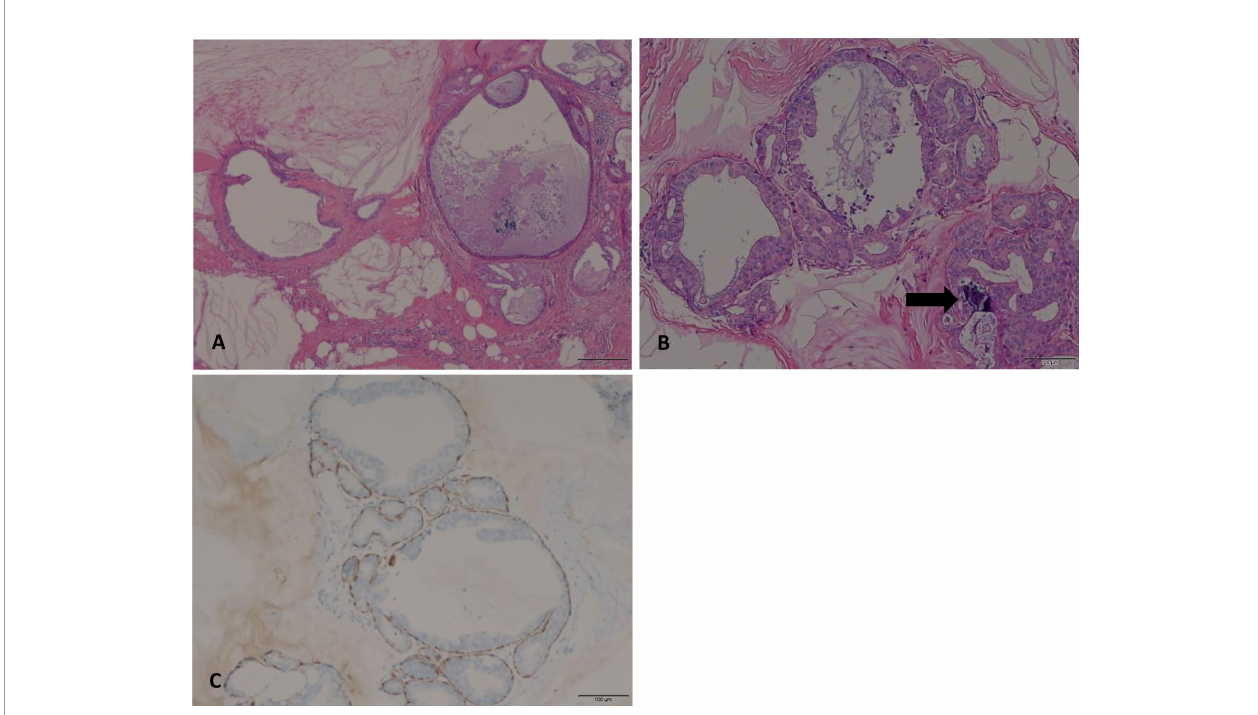
FIGURE 2 | (A) Multiple cystic enlarged ducts containing mucinous secretion and extravasated mucin in the stroma (HE, original magni fi cation, 40×). (B) Multifocal neoplastic proliferation of epithelial cells (>2mm in size) with low-grade cytological atypia. Microcalci fi cations are also noted within the enlarged ducts (arrow) (HE, original magni fi cation, 100×). (C) Myoepithelial cells at the outer layer of the duct were stained with P63 (original magni fi cation,